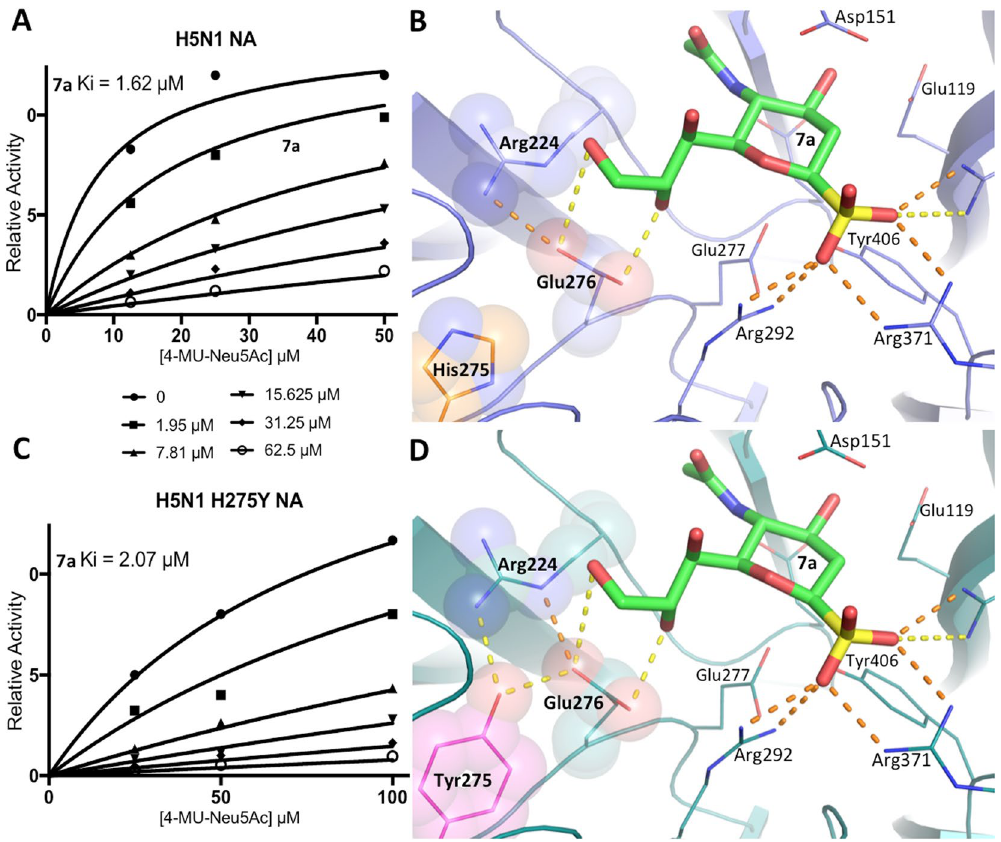
Figure 4. Inhibition of avian-origin H5N1 N1 by sulfo-sialic acid analogue 7a . ( A ) 7a inhibits wildtype N1 with an inhibitory constant ( K i ) of 1.62 μ M. ( B ) Predicted binding of 7a to the wildtype N1 active site. ( C ) 7a inhibits His275Tyr oseltamivir-resistant N1 with a similar potency to that of wildtype N1. ( D ) Predicted binding of 7a to the His275Tyr N1 active site shows that the 7a glycerol side chain maintains the same interactions with the Glu276 side chain. Key residues relating to His275Tyr drug resistance are shown inside transparent spheres. Electrostatic interactions of the inhibitor sulfo group and glycerol moiety are indicated by dashed lines, with stronger ionic interactions colored orange. The binding analysis was performed with MOE based on the structure of A/Vietnam/1203/04 (H5N1) NA (PDB ID 3CKZ) 26